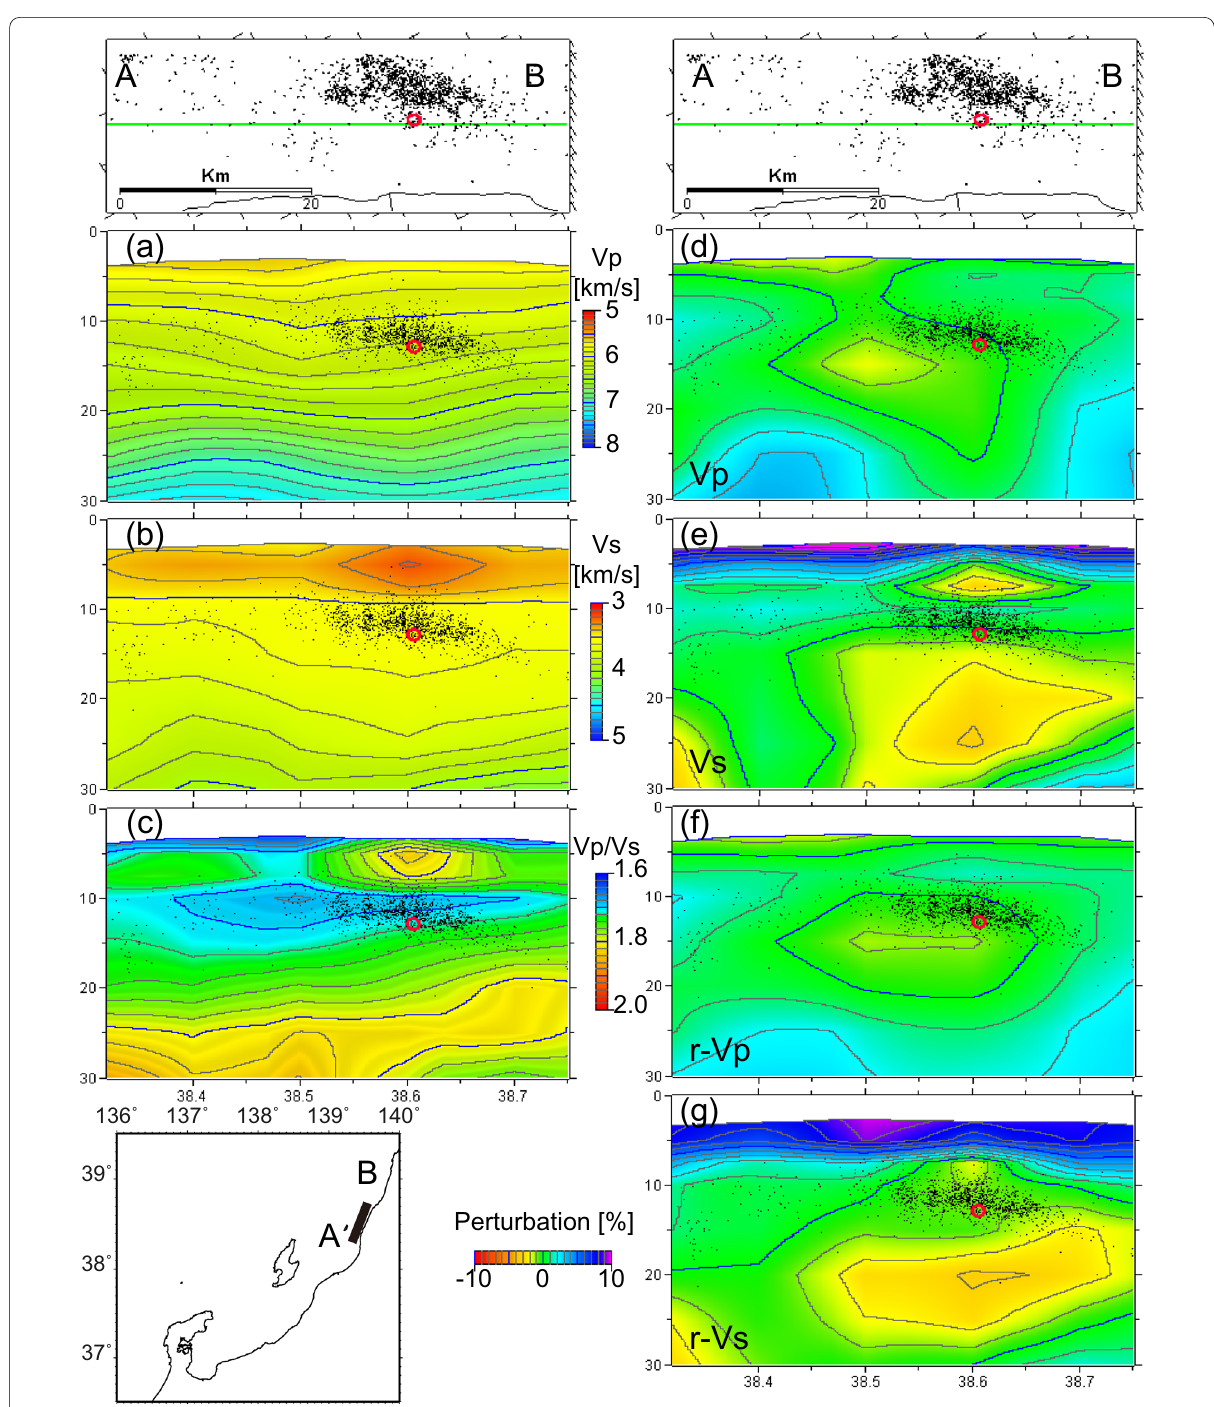
Fig. 16 NEN–SWS cross section of seismic velocity structure and restored resolution test around the 2019 offshore Yamagata earthquake. Red circles denote the hypocenter of the 2019 offshore Yamagata Earthquake determined with the 3D velocity